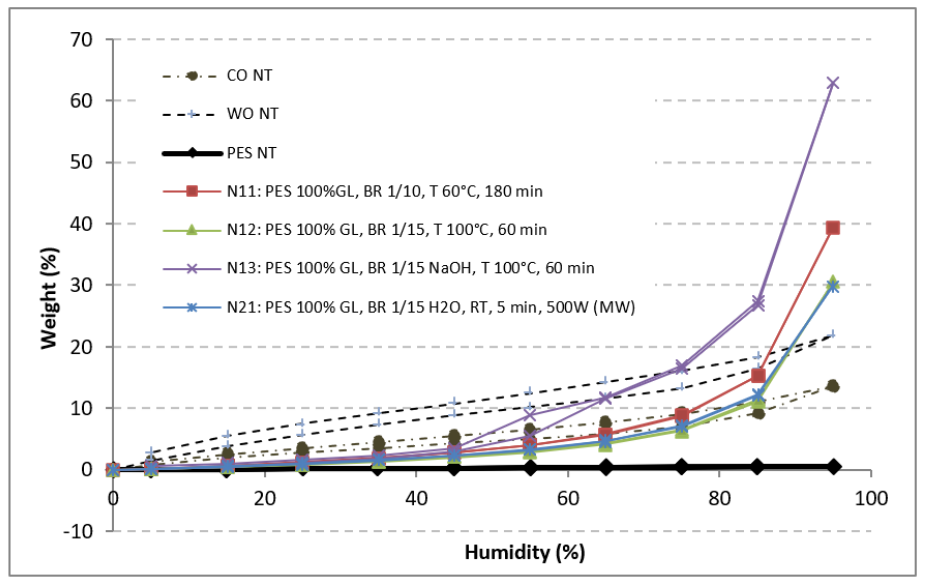
Figure 3. Water absorption/desorption of PES, CO and WO (Table 1) and the GL-treated PES fibers (Table 4).